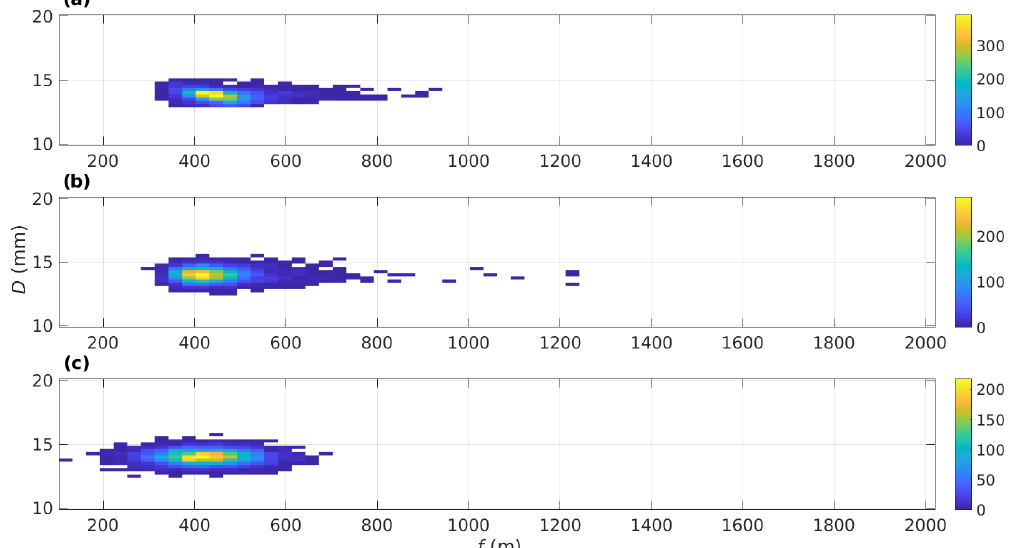
Figure 5. Distributions of the Monte Carlo simulation (MCS) input values used for calculating σ T pling, (b) assuming N(f − 2 ,D) , and (c) assuming N(f,D) . All distributions contain 5337 samples. (R) uncertainty envelopes generated using MCS with three different sets of input values. Table 4. σ T f Location Period Resampling N(f − 2 ,D) N(f,D) Ascension 20160906–20170930 0.15 Darwin